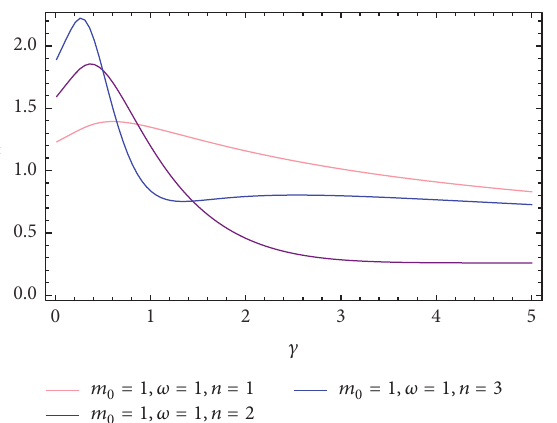
Figure 10: Uncertainty in position versus 𝛾 .